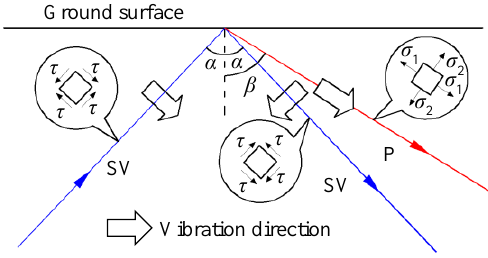
Figure 1. Reflection of SV wave on the free surface.